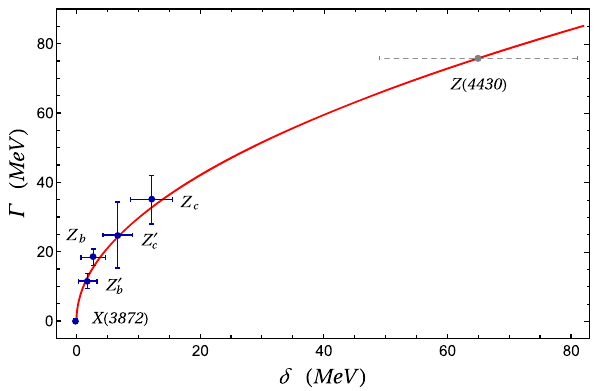
Fig. 1 Comparison between the experimental values of δ and (cid:5) for the √ δ law. All the ground state tetraquarks XZ resonances and the (cid:5) = A fit the curve remarkably well, with a value of the fitted parameter A = 9 . 4 ± 1 . 5 MeV 1 / 2 [33] common to both the charm and beauty resonances. We also report the expected with of the Z ( 4430 ) , which is underestimated with respect to the observed one. Indeed, being the Z ( 4430 ) an excited state, the decay towards a ground state tetraquark (rather than a meson pair) is also